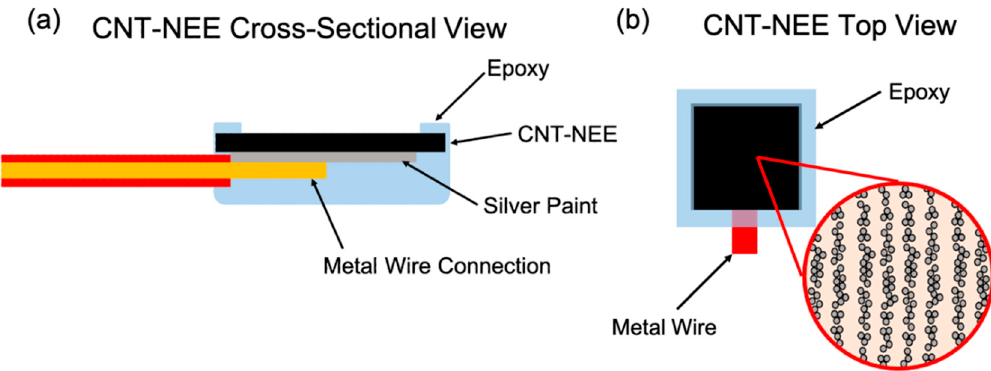
Figure 3. Illustration of the CNT-NEE assembly. ( a ) Cross-sectional view of the fabricated CNT-NEE. ( b ) Top view of the CNT-NEE with a higher magnification illustration of the layering of CNTs and HNBR.